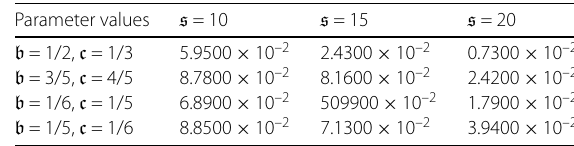
Table 2 Absolute error in boundary conditions of y ( t ) of Example 6.1 for different values of parameters b and c